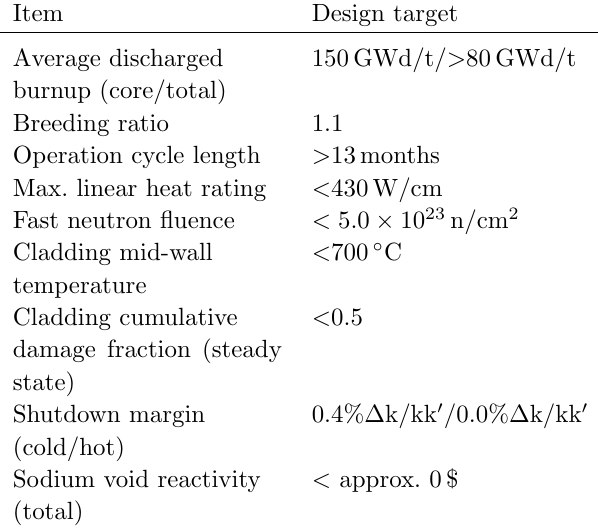
Table 1. Core design target.